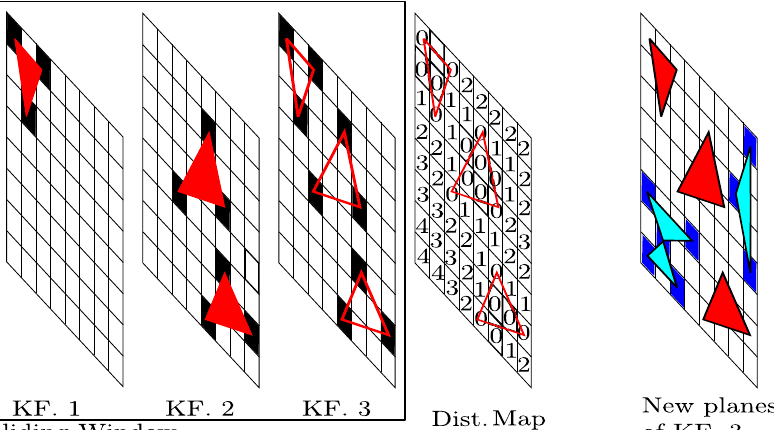
Figure 4. The example shows a sliding window formed by two old keyframes and one new keyframe. In the first keyframe (KF. 1), there is an active planar region, represented by the triangle (red) and its vertices (black). The second keyframe (KF. 2) has two active planar regions. The third keyframe (KF. 3) shows projections of the vertices from the previous keyframes (black). The distance map is exemplified in the fourth frame. Elements with zero indicate occupied positions with old edges. Elements with values above zero represent the distance from the element to the edge. Thus, new planes that fall at a certain distance from the edges of old activated planes are accepted to be activated in the new keyframe. Finally, the last frame presents new activated planes (cyan) and their vertices